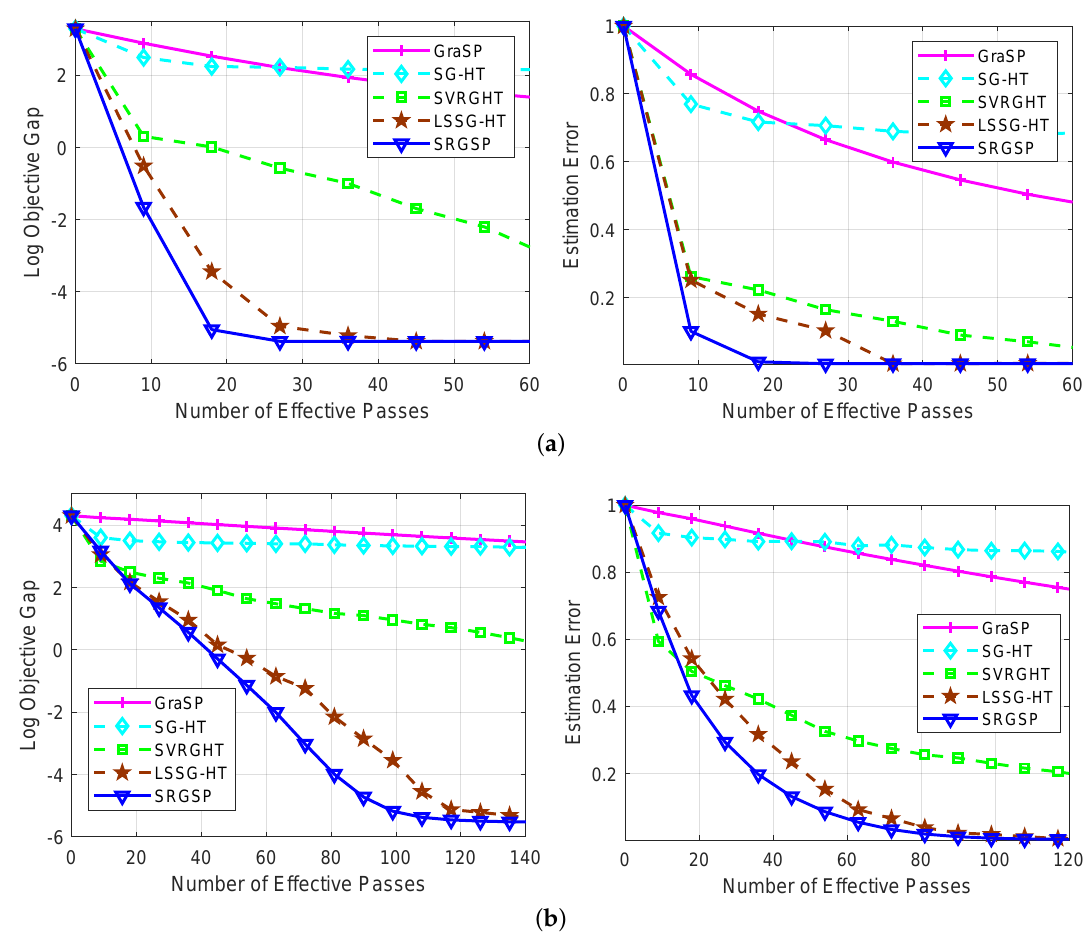
Figure 1. Comparison of gradient support pursuit (GraSP) [22], gradient support pursuit (SG-HT) [23], stochastic variance reduced gradient with hard thresholding (SVRGHT) [24], loopless semi-stochastic gradient descent with less hard thresholding (LSSG-HT) [34] and SRGSP for solving sparse linear regression problems on synthetic data. ( a ) n = 2500, d = 5000, s ∗ = 250; ( b ) n = 5000, d = 10,000, s ∗ =